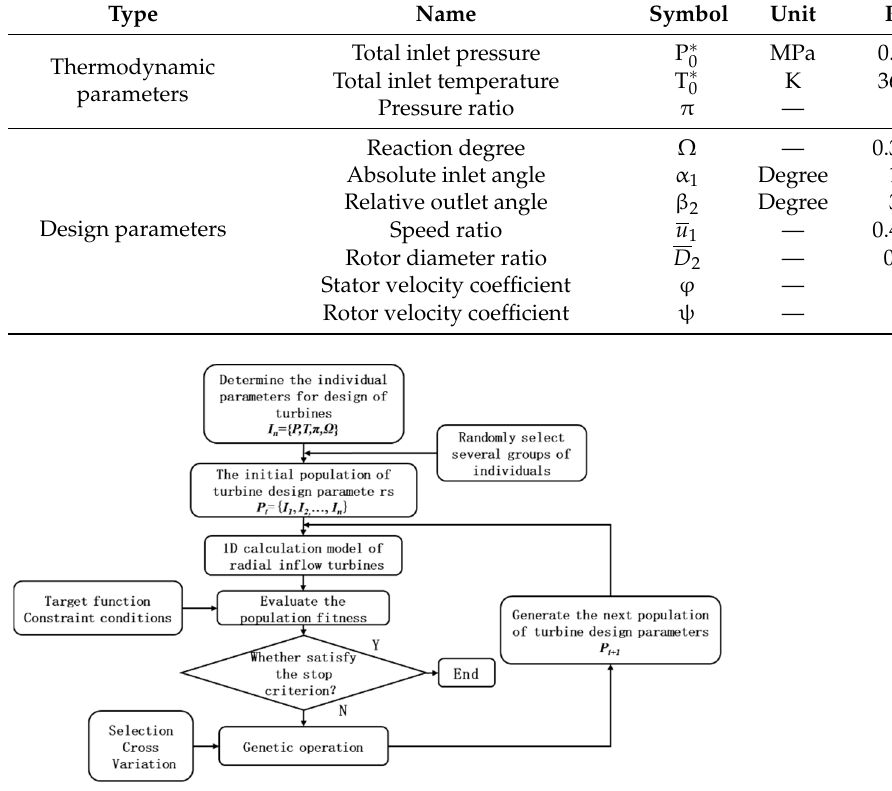
Figure 1. Flowchart of genetic optimization algorithm of radial inflow turbines. Table 2. Constraint conditions in the radial inflow turbine design [32].